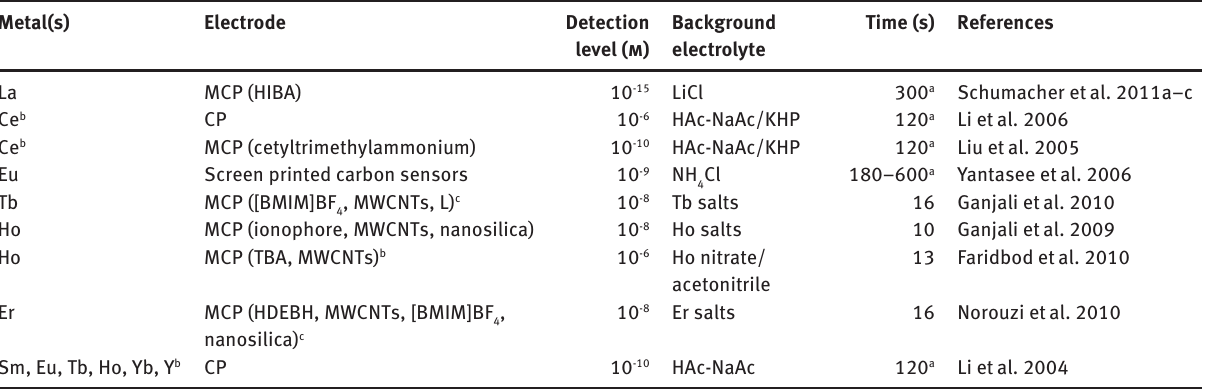
Table 5 Summary of electrochemical data of Ln from CP and MCP electrodes.